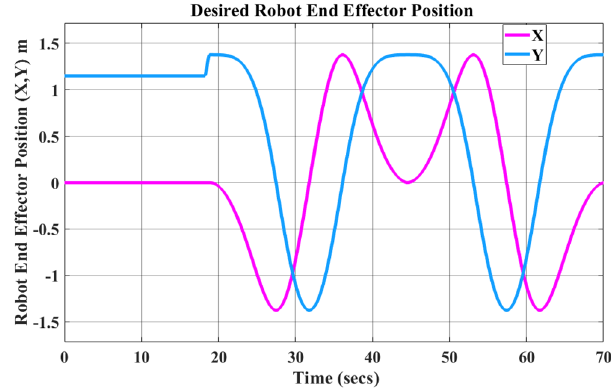
Figure 14. Robot end effector trajectory with time axis.